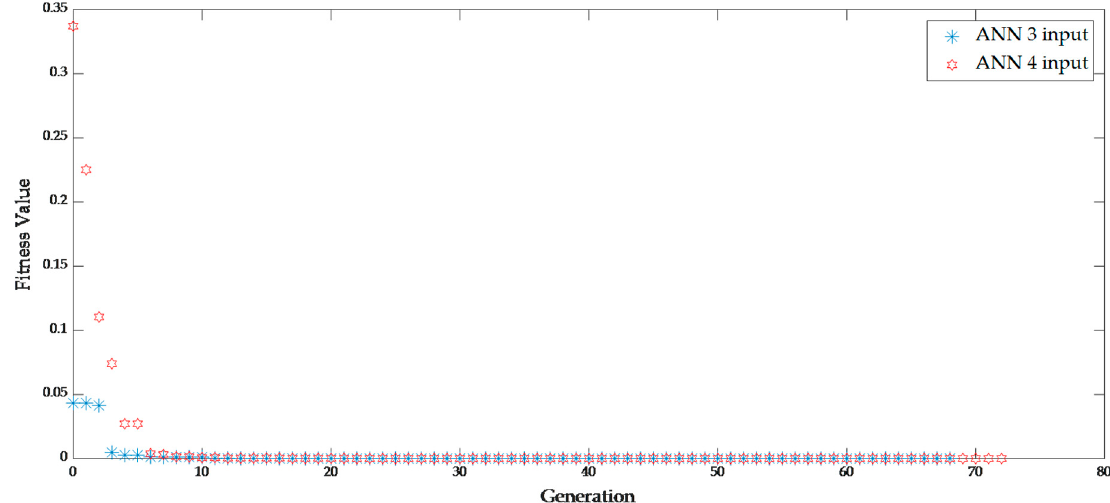
Figure 9. Trends of MSE for both ANNs optimized through a GA.